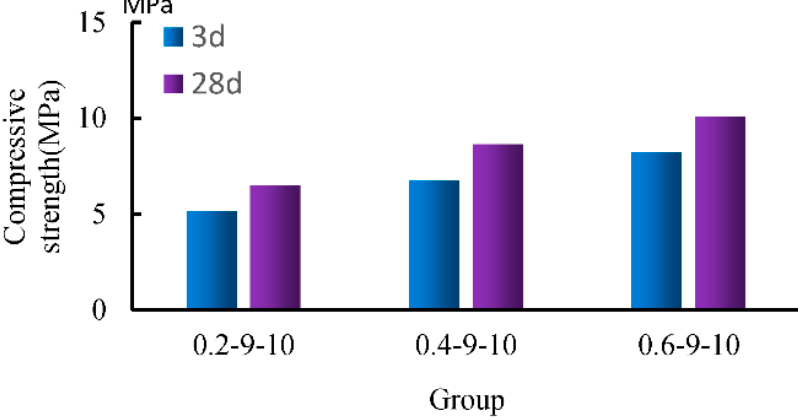
Figure 1. Diagram of compressive strength variation with fiber content.